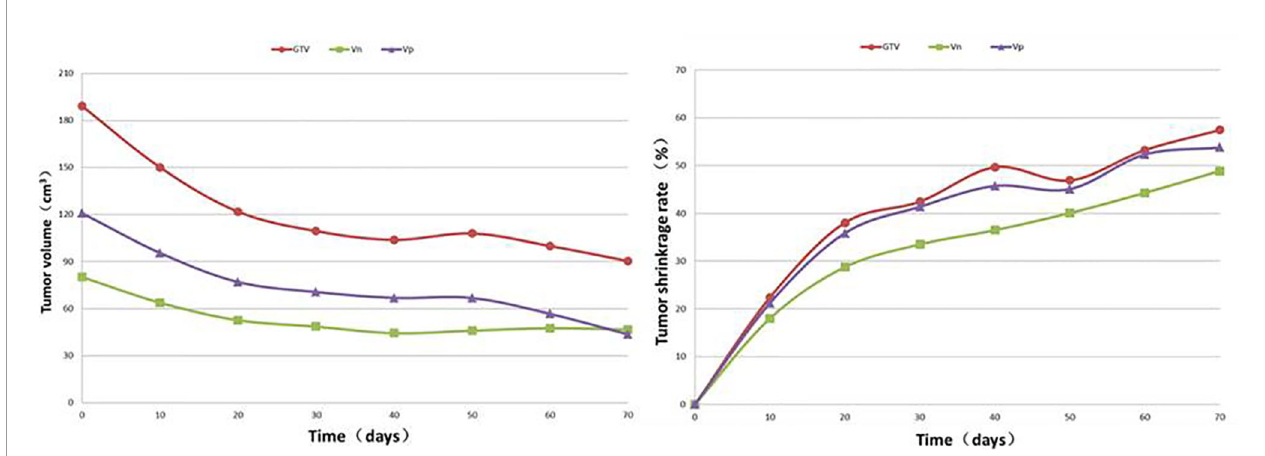
FIGURE 2 | Regularity of the average value and shrinkage rate for the V P, V N and GTV at different times after targeted therapy in 27 patients.